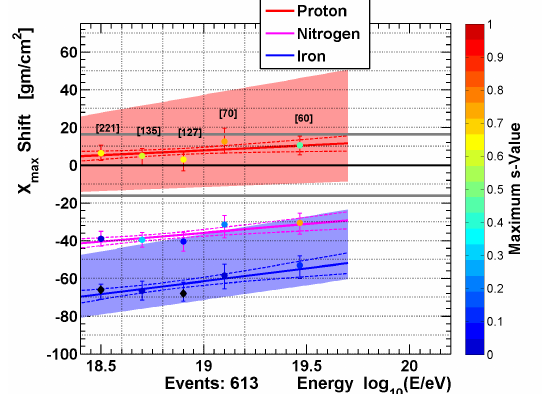
(b) (cid:104) X max (cid:105) shift of Middle Drum data required to maximize Cramér-von Mises test probability relative to predictions of proton, nitrogen, and iron.